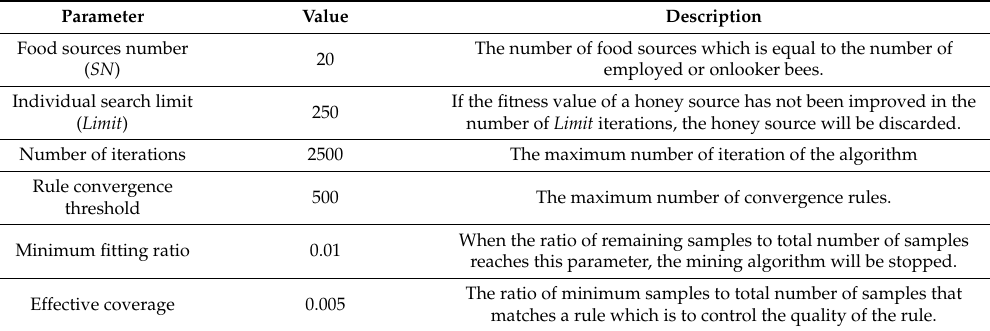
Table 4. Parameter settings of improved hybrid artificial bee colony algorithm based on the mutation of inferior solutions (MHABC)-cellular automata (CA)